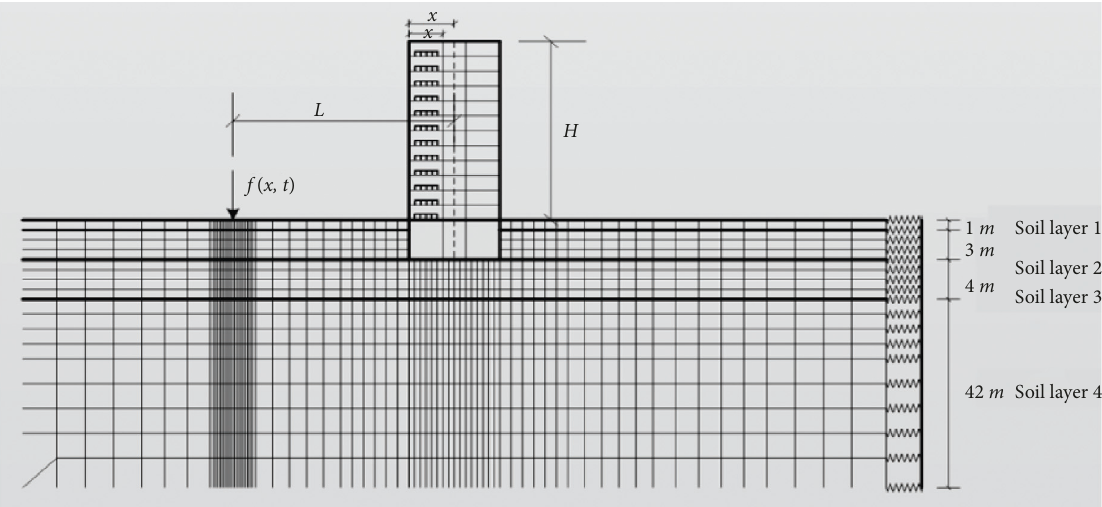
Figure 11: Schematic diagram of soil-building-isolation slab finite element analysis grid.